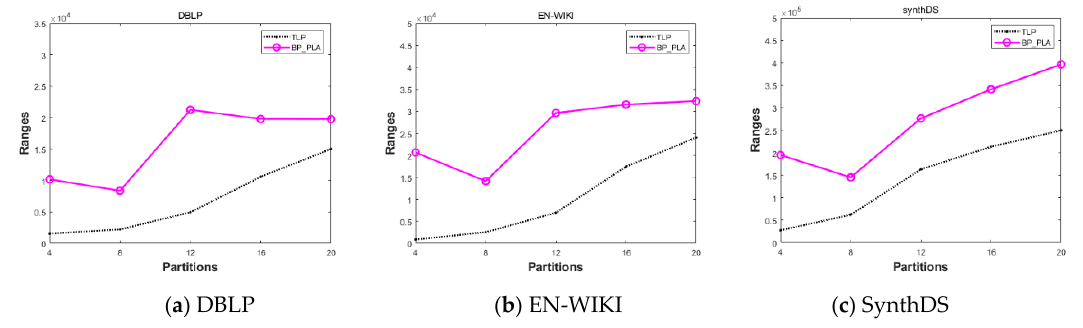
Figure 13. Partition ranges for different partition numbers.